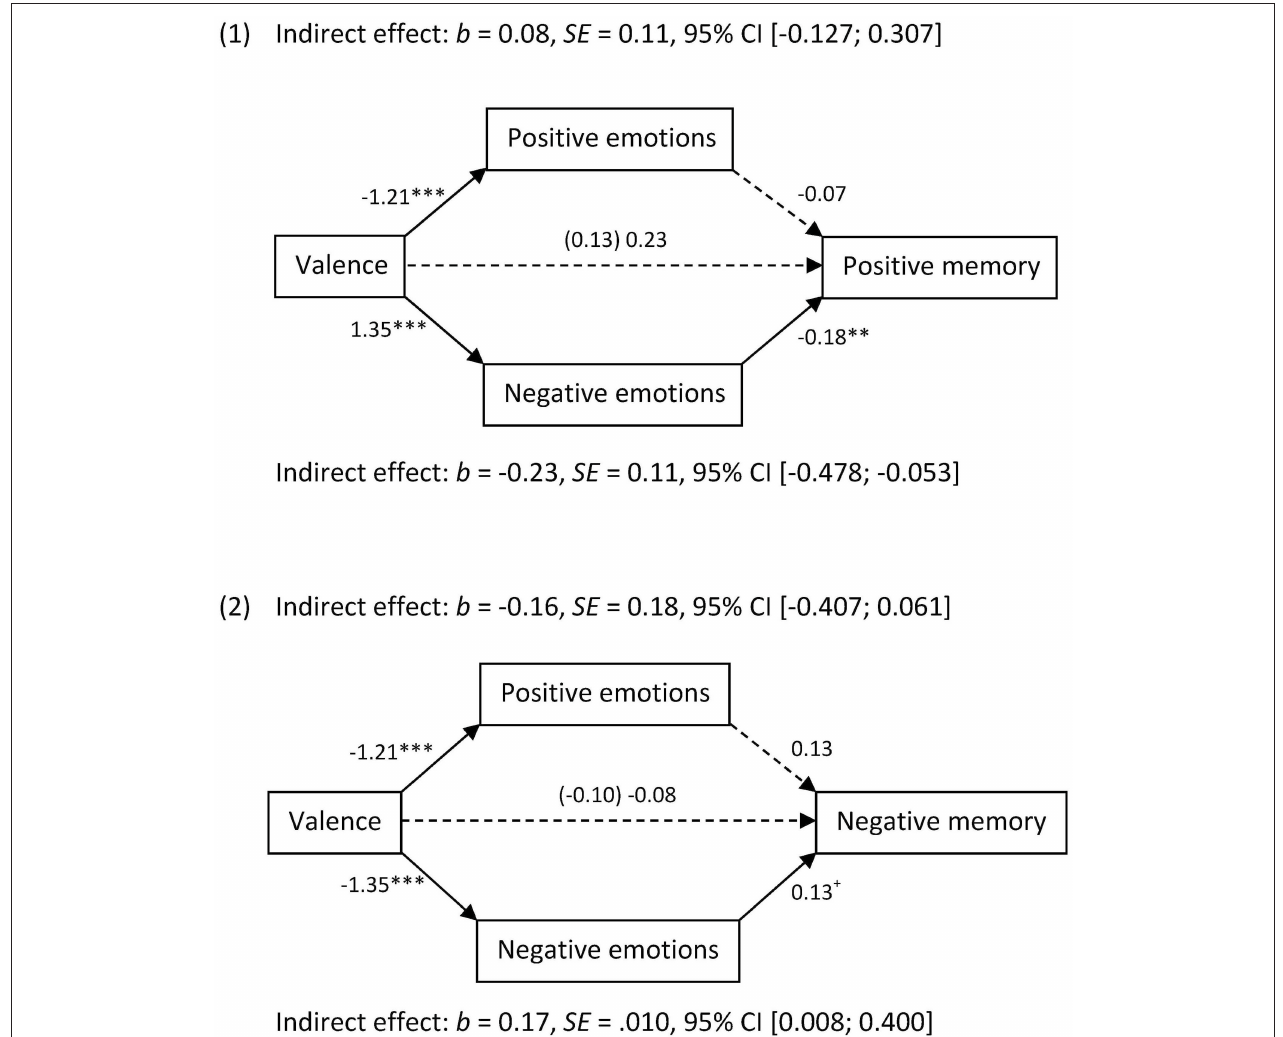
FIGURE 1 | Unstandardized coefficients of bootstrapping analyses of the effect of using patient testimonials on memory performance regarding positive (1) or negative (2) DBS-related information via elicited positive or negative